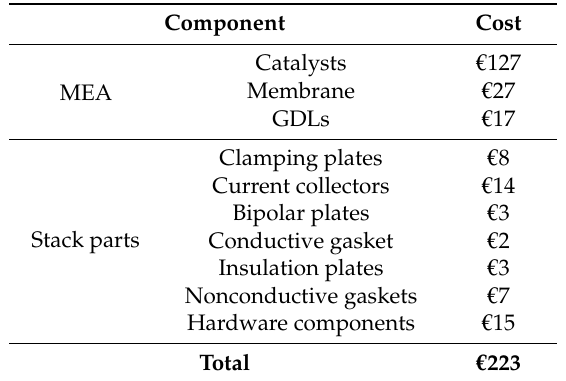
Table 2. Cost of raw materials for the components for a single unit (200 W power output) produced on a large